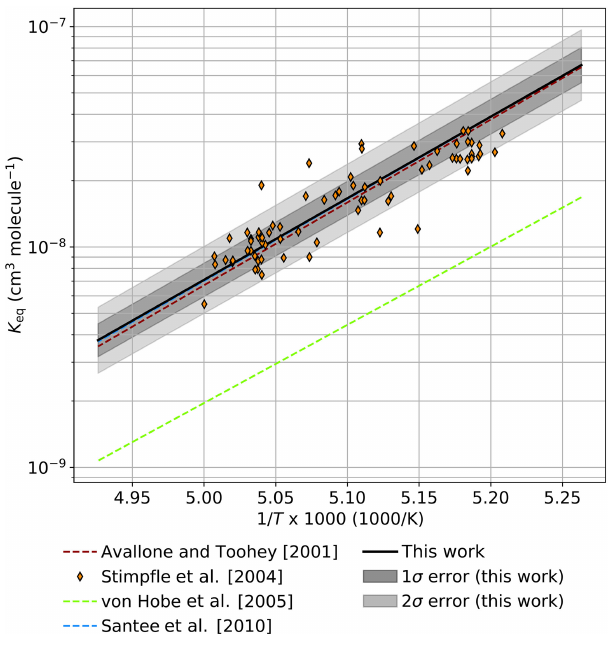
Figure 6. Comparison of extrapolated K eq values from the third-law fit in this work ( K eq = 2 . 16 × 10 − 27 e ( 8527K /T) cm 3 molecule − 1 ) to atmospheric observa- tions. K eq (solid black) and error boundaries (gray shaded regions) determined in this study are extrapolated to the temperature range of 190–203K. Expressions for K eq derived from previous atmo- spheric measurements are presented as dashed lines. Observations of [ ClOOCl ] / [ ClO ] 2 from the nighttime ER-2 flight on 3 February 2000 in the SOLVE/THESEO mission out of Kiruna, Sweden, are indicated as orange